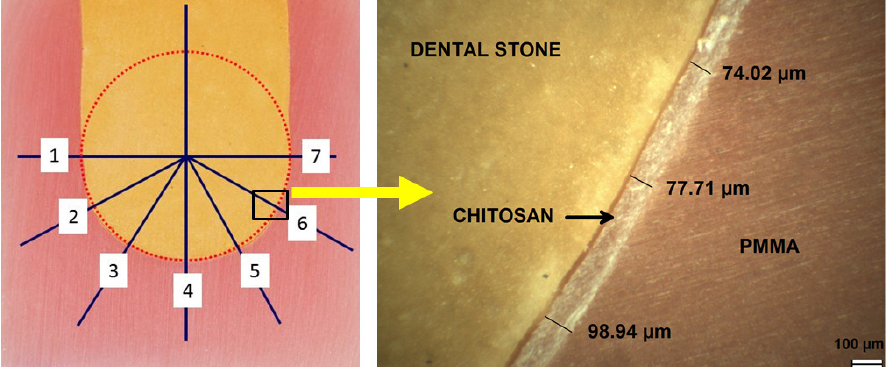
Figure 6. Measuring points to assess chitosan coating thickness at the depth of the U ‐ shaped profile